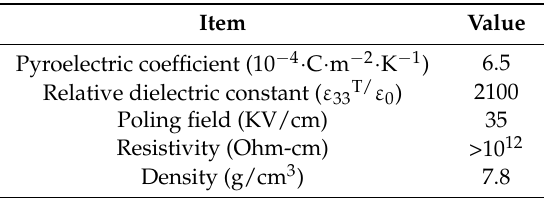
Figure 4. Schematic diagram for the PZT cell installed on the top of commercial capacitors. Table 1. Properties of the bulk PZT